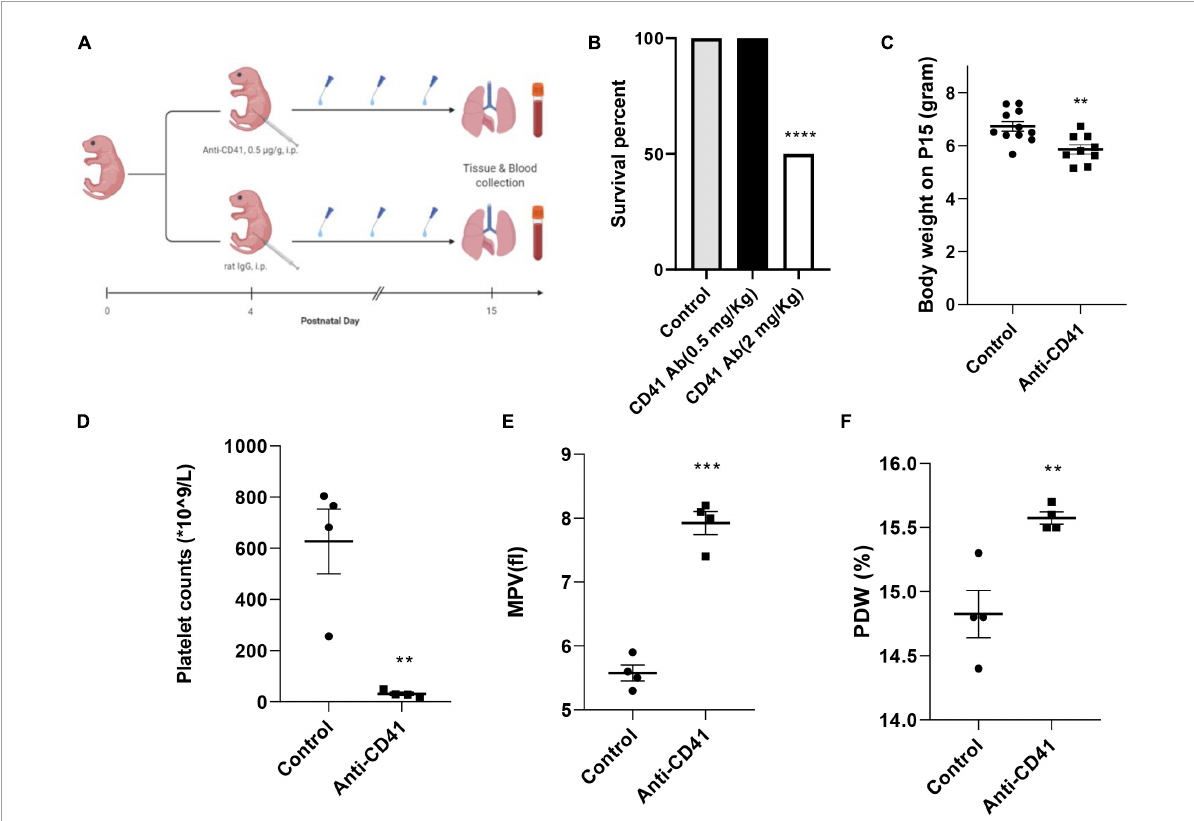
FIGURE1 Effective platelet depletion with anti-CD41 antibody resulted in weight loss in newborn mice. Experimental scheme (A) of the newborn mice treated with anti-CD41 antibody or isotype (0.5 mg/Kg body weight, intraperitoneal) at postnatal day 4 (P4), P7, P10, and P13. Mice were sacrificed on day 15. Mortality (B) and body weight (C) on postnatal day 15 from mice in control ( n = 11) and anti-CD41 group ( n = 10). Platelet counts (D) , mean platelet volume (E) and platelet distribution width (F) in mice treated with anti-CD41 antibody or isotype, n = 4 in each group. Values are expressed as mean ± SEM, ** p < 0.01, *** p <